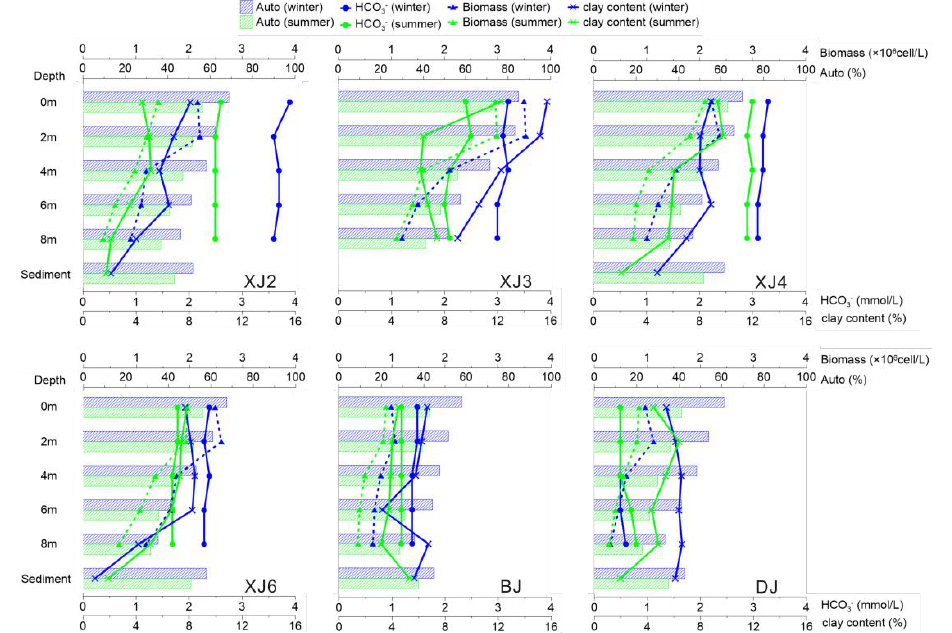
Figure 8. Vertical variation in autochthonous ratio of organic carbon and relevant biogeochemical indexes in water column and surface sediments of Pearl River.